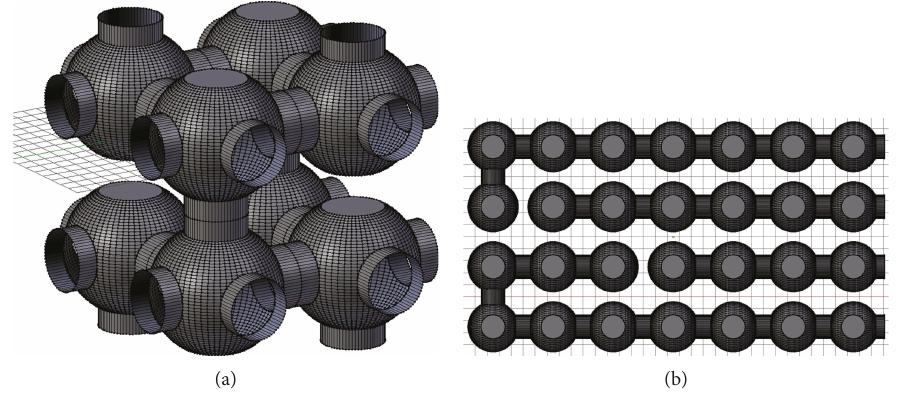
Figure 3: DENORMS design variations: (a) labyrinth; (b) space coiling mixed